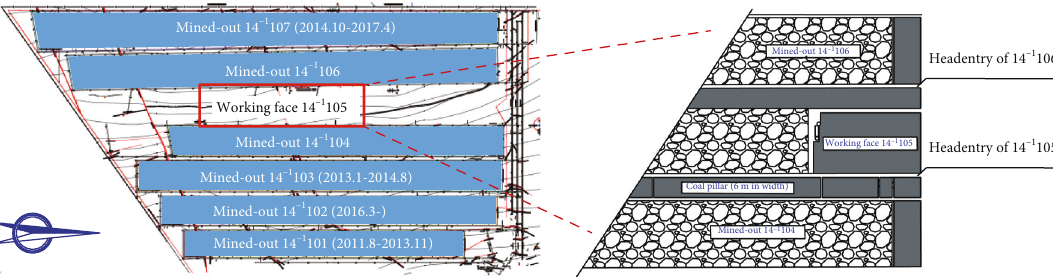
Figure 1: Mine location and panel layout of the test areas.